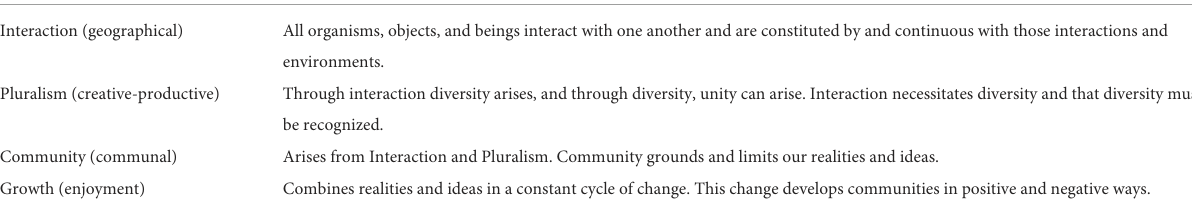
TABLE 1 Dimensions of Indigenous pragmatism. Indigenous pragmatism Interaction